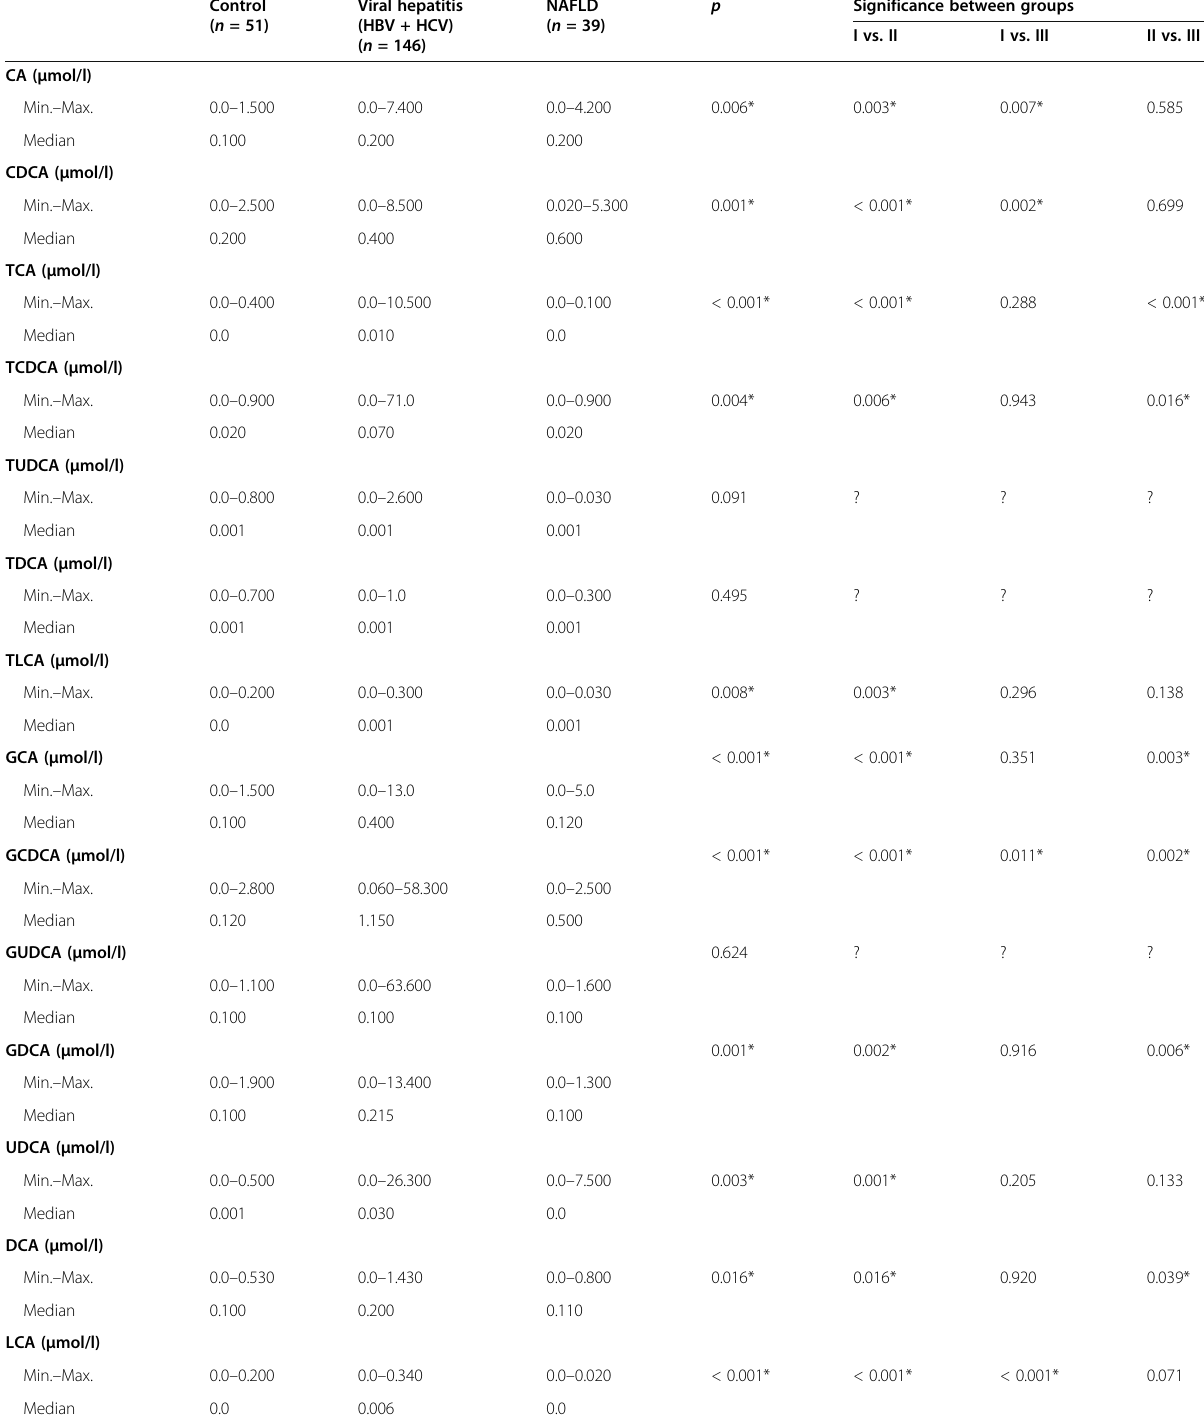
Table 2 Comparison of 14 bile acid composition among the three studied